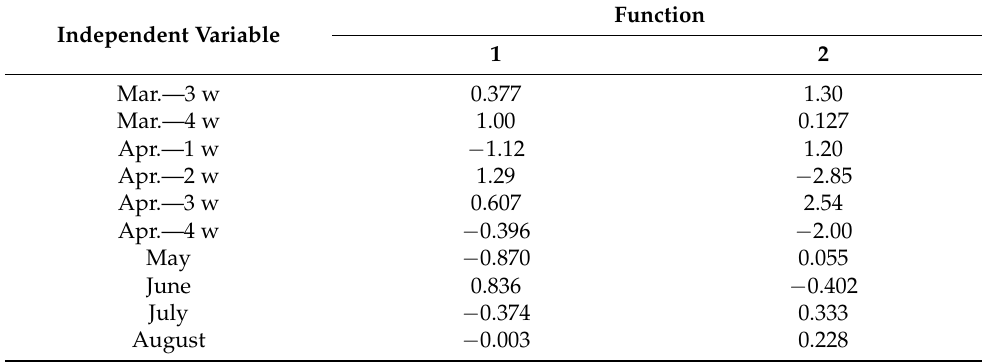
Table 5. Standardized canonical discriminant function